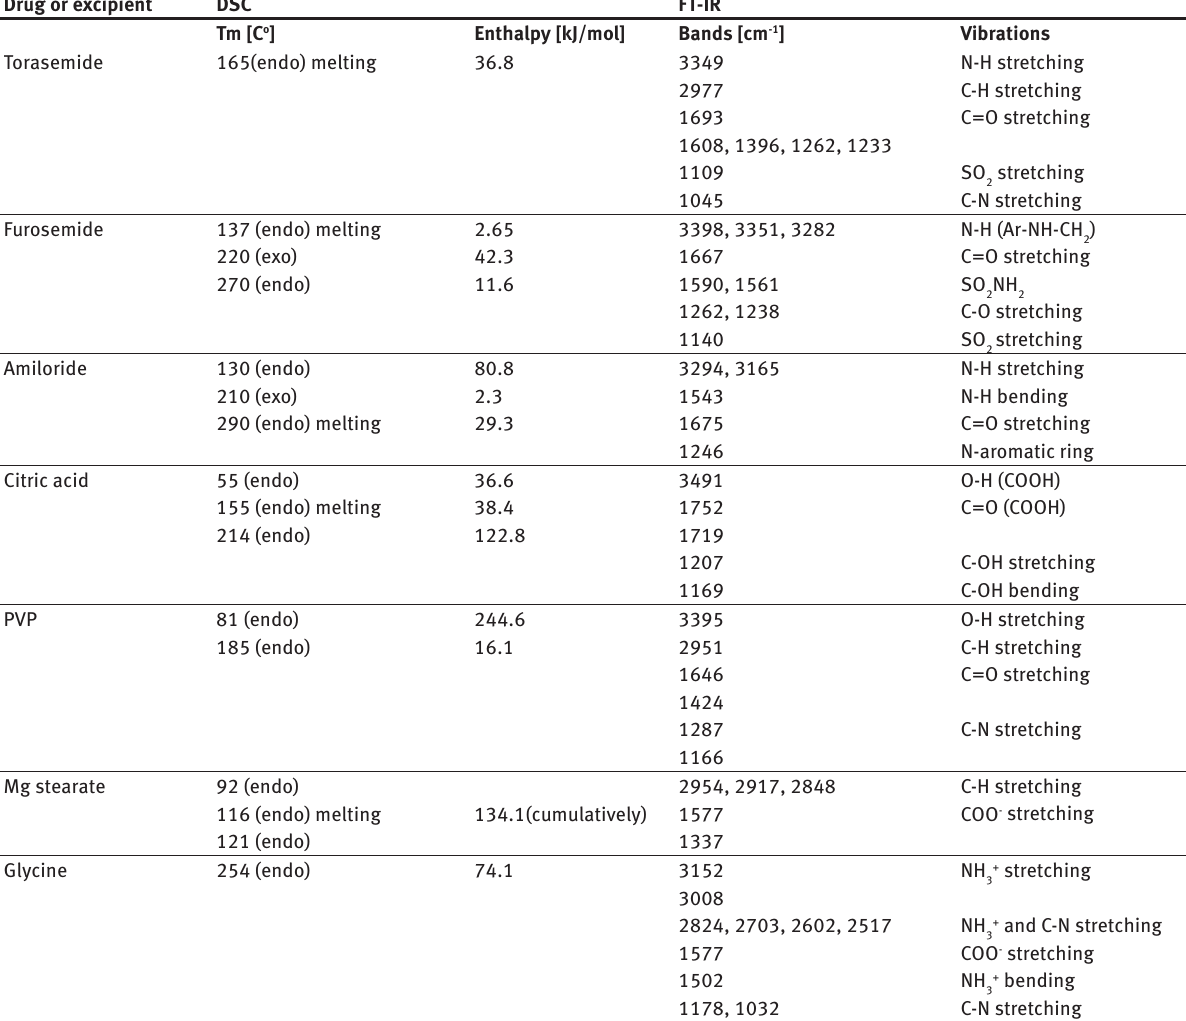
Table 2 : DSC and FT-IR characteristics of torasemide, furosemide, amiloride and operative excipients (not stressed) Drug or excipient DSC Torasemide